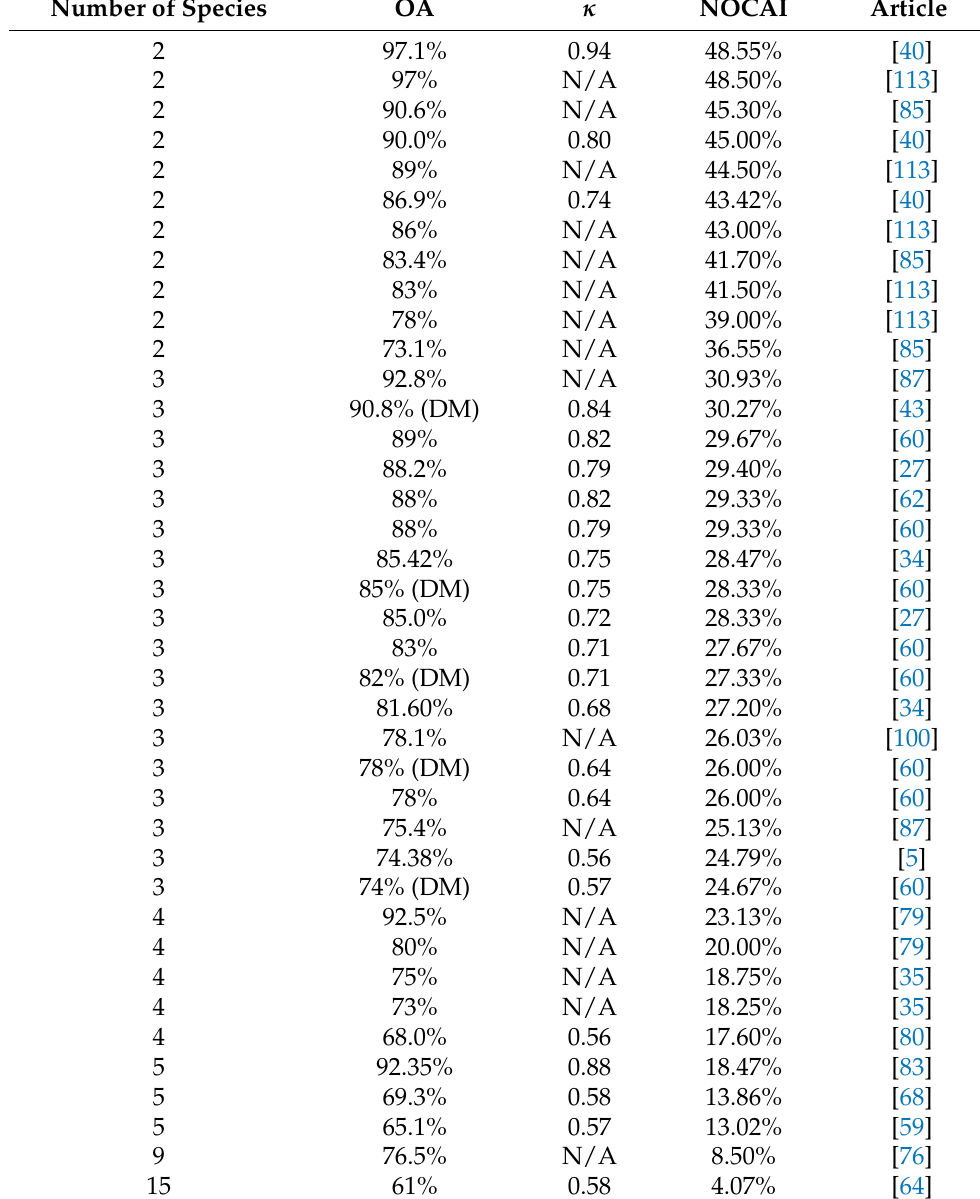
Table A2. List of results of reviewed studies where species classification was performed an intensity+ feature group; list sorted by species number and overall accuracy; DM—additional information for studies where trees were delineated manually.